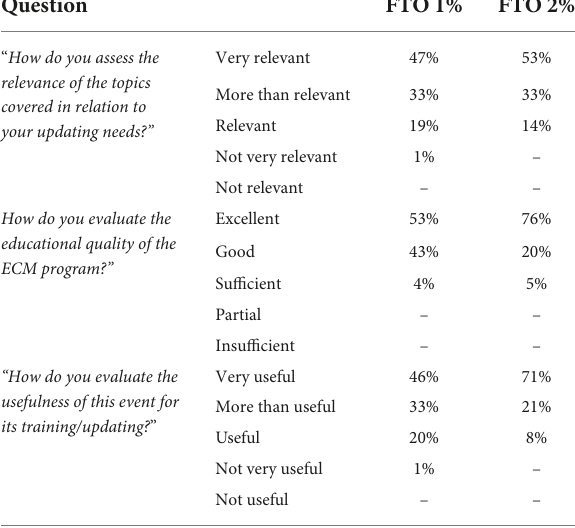
TABLE 4 Trainees’ evaluation of FTO1 and 2’